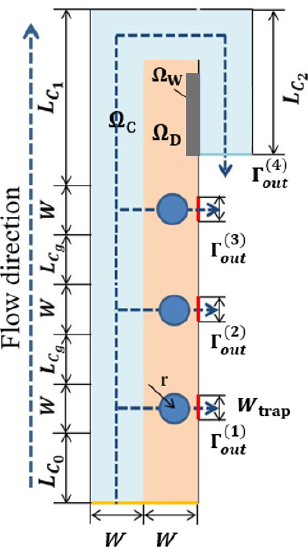
Figure 9. The computational domain Ω = Ω C ∪ Ω D of a three-cell capture unit with the capture Figure 9. The computational domain 𝛺 = 𝛺 (cid:2887) ∪ 𝛺 (cid:2888) of a three-cell capture unit with the capture chan- channel perpendicular to the inlet channel, where Ω D is the design domain, Ω C is the bypass channel, nel perpendicular to the inlet channel, where 𝛺 (cid:2888) is the design domain, 𝛺 (cid:2887) is the bypass channel, and 𝛺 (cid:2907) is artificial wall. and Ω W is artificial wall.